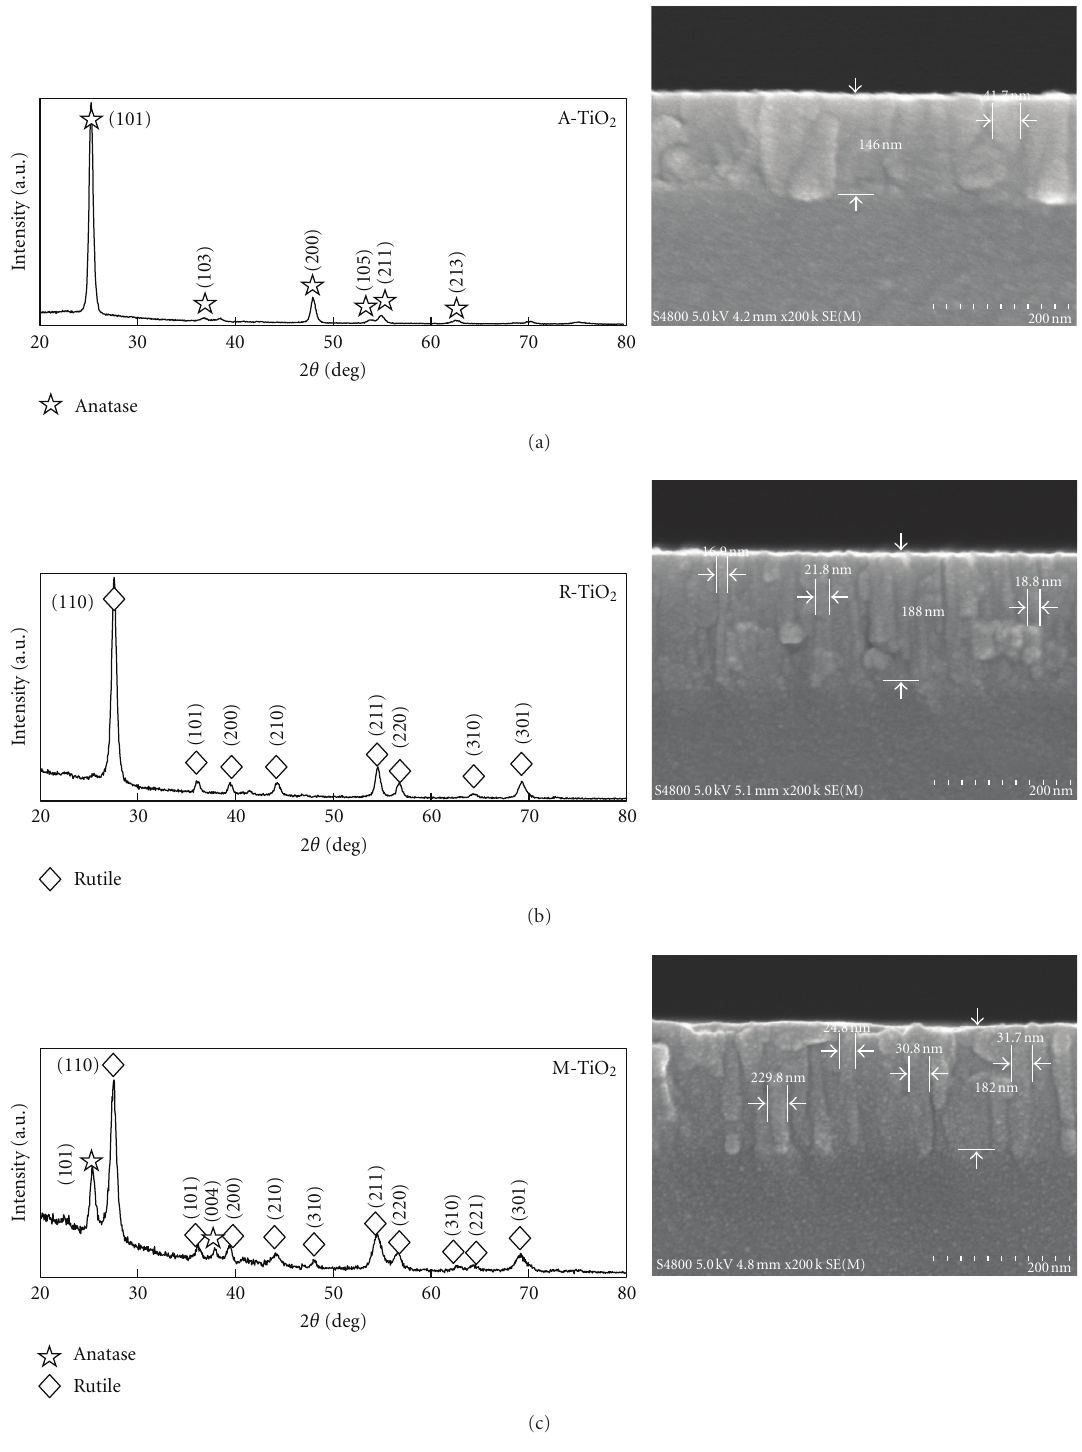
Figure 1: XRD patterns and FE-SEM cross-sectional images of the A-, R-, and M-TiO 2 thin film.